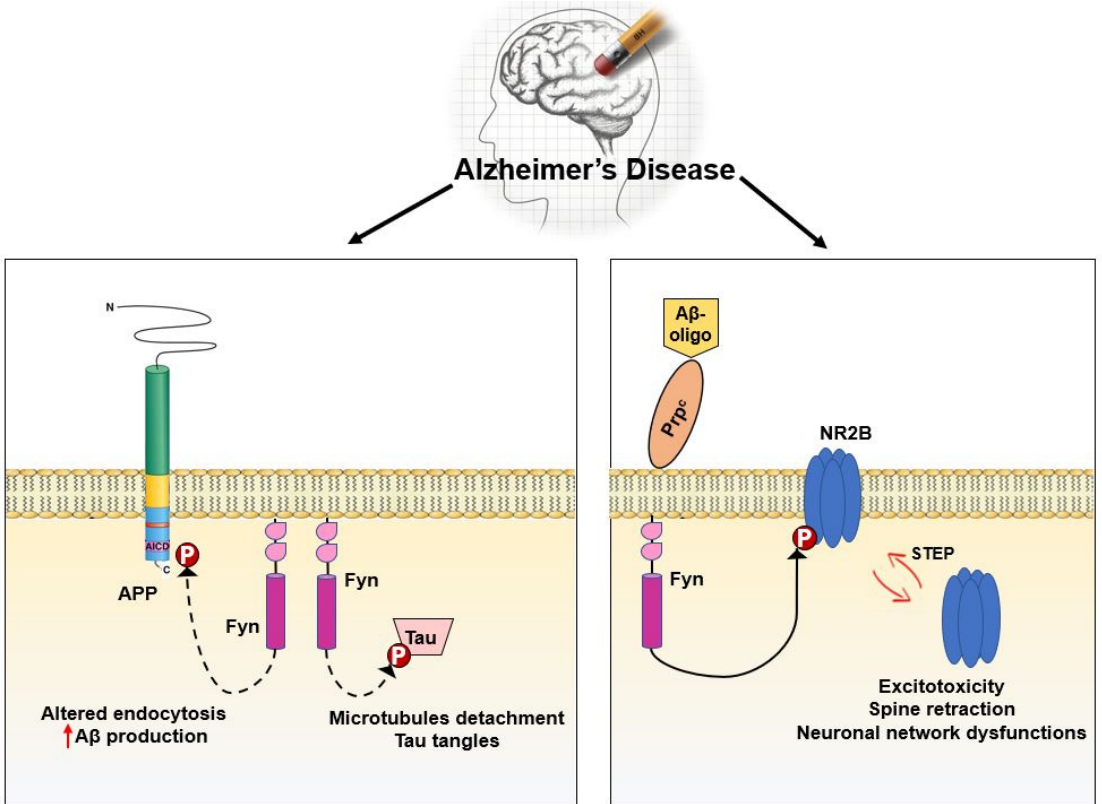
Figure 5. Fyn target proteins in AD neurons. Left: When overactivated, Fyn promotes phosphorylation either of APP at Tyr682 or Tau at Tyr18. These target protein hyperphosphorylations activate downstream pathways finally resulting in AD-related neuronal dysfunction and death. Right: A proposed mechanism by which Fyn, after interacting with the A β oligomers-Prion like protein complex, phosphorylates NR2B receptor and triggers excitotoxicity.